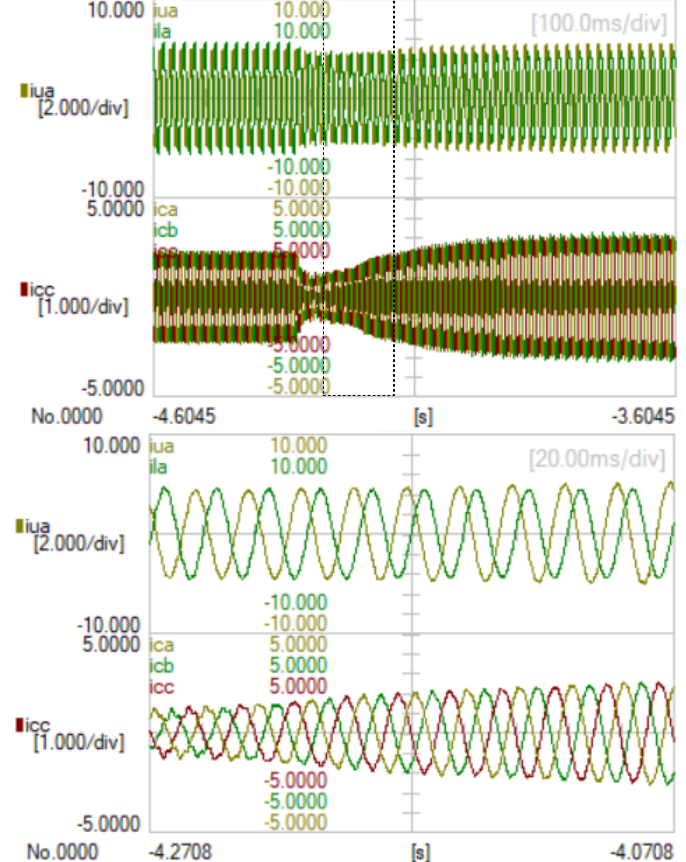
Figure 15. Steady state and dynamic response of current arm and circulating currents in second event.